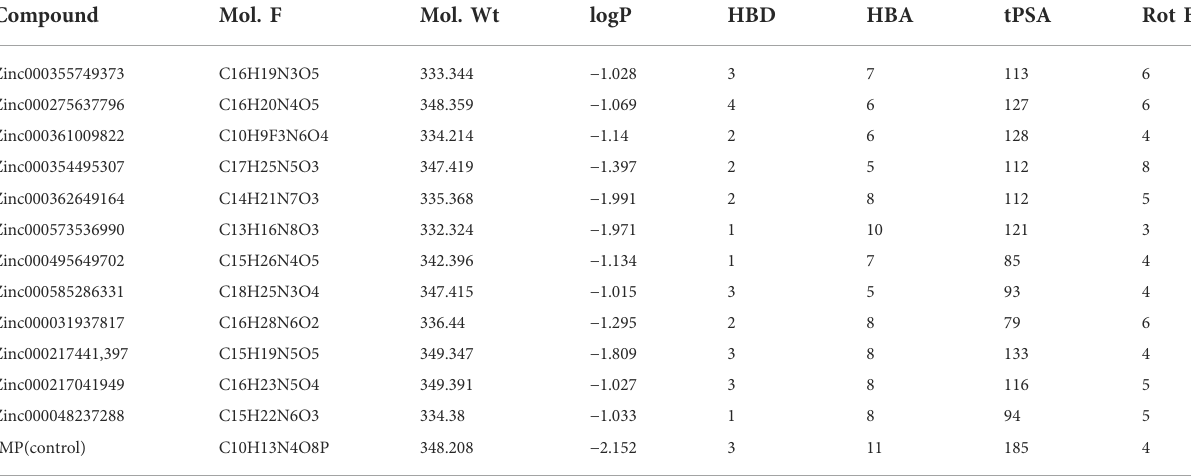
TABLE 2 Characterization of topmost ligangds obtained from double-step docking. Compound